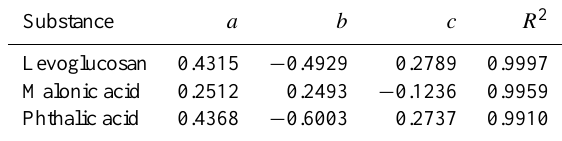
Table 3. The three-parameter fit values for the hygroscopic growth of the investigated organic aerosol particles with Eq. (2).